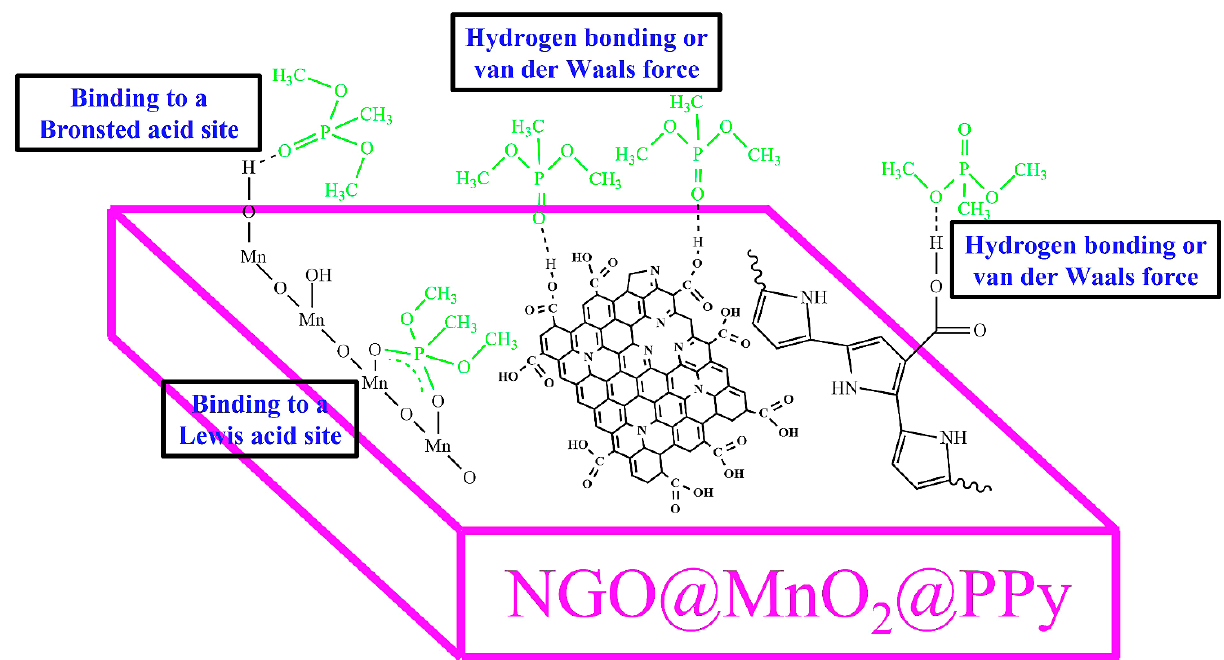
Figure 11. The proposed mechanism of DMMP adsorption on the NGO@MnO 2 /PPy composites with a Bronsted acid site, Lewis acid site, and hydrogen bonding or van der Waals force. The figure is not to scale.